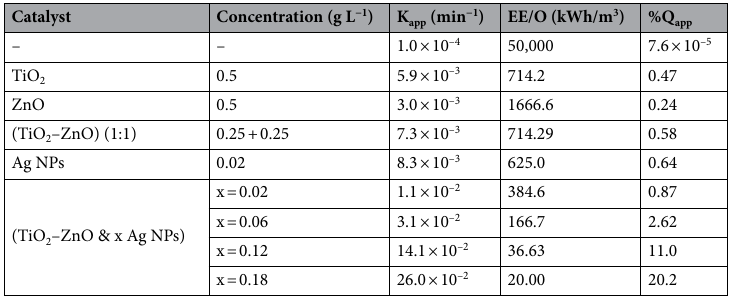
Table 2. The apparent rate constants, electrical energy per order, and the apparent quantum yield for the photocatalytic degradation of 1.0 × 10 –4 M dye pollutant upon UV irradiation.